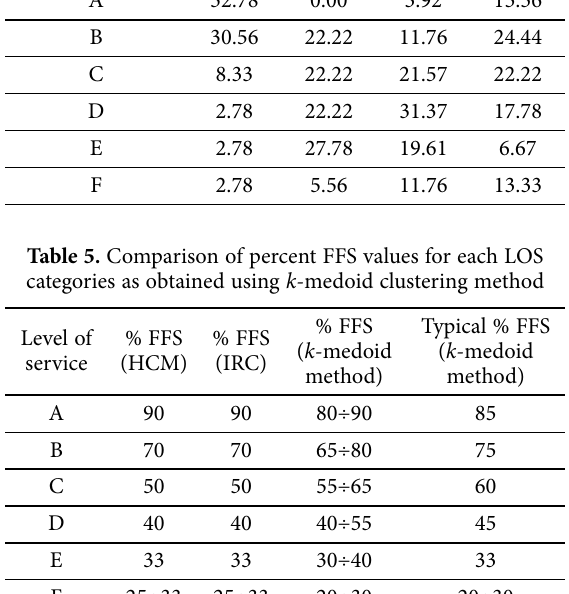
Table 4. Percentage of travel runs under levels of service categories for urban street classes in Kolkata city Level of service